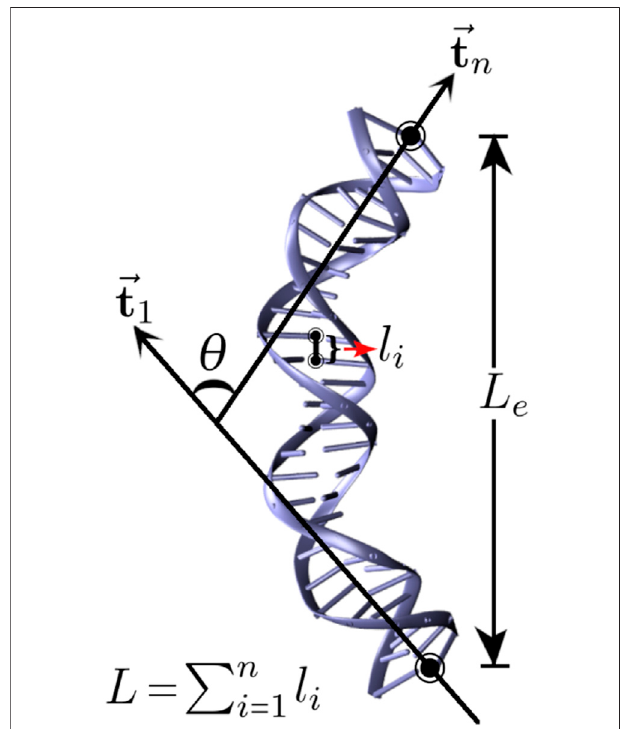
FIGURE 1 | Schematic representation of a dsDNA where L e represents its end-to-end distance, L represents its contour length, and θ represents the bending angle, the angle between unit vectors (cid:1) t 1 and (cid:1) t n